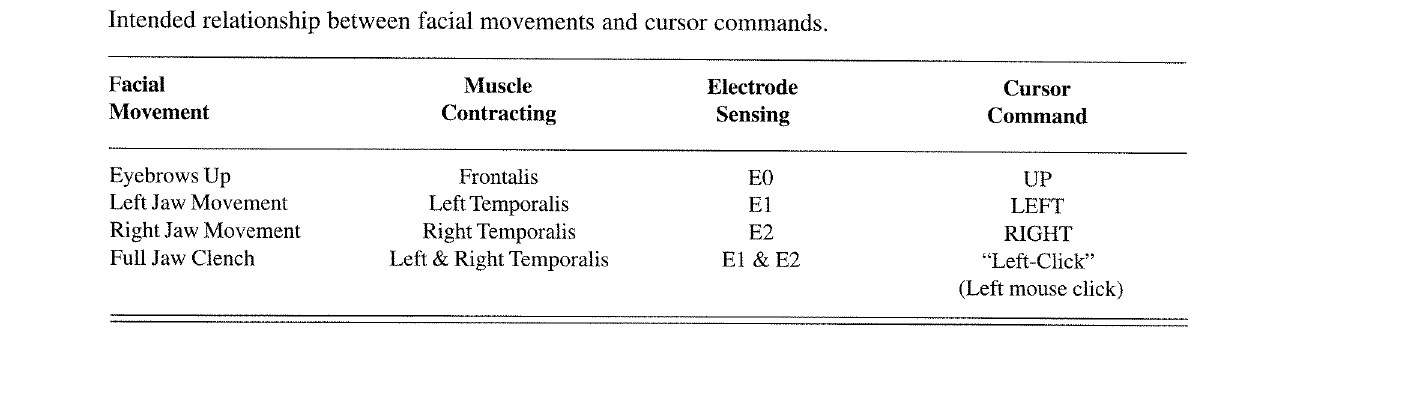
Figure 2. Application of the monitoring electrodes required for the EMGIEEG HCI System through the use of a headband : a) Mr. Julio Blandon demonstrates the lightweight headband consisting of the four monitoring electrodes ; b) DSP board and interface circuitry used in the Human Computer Interface System.